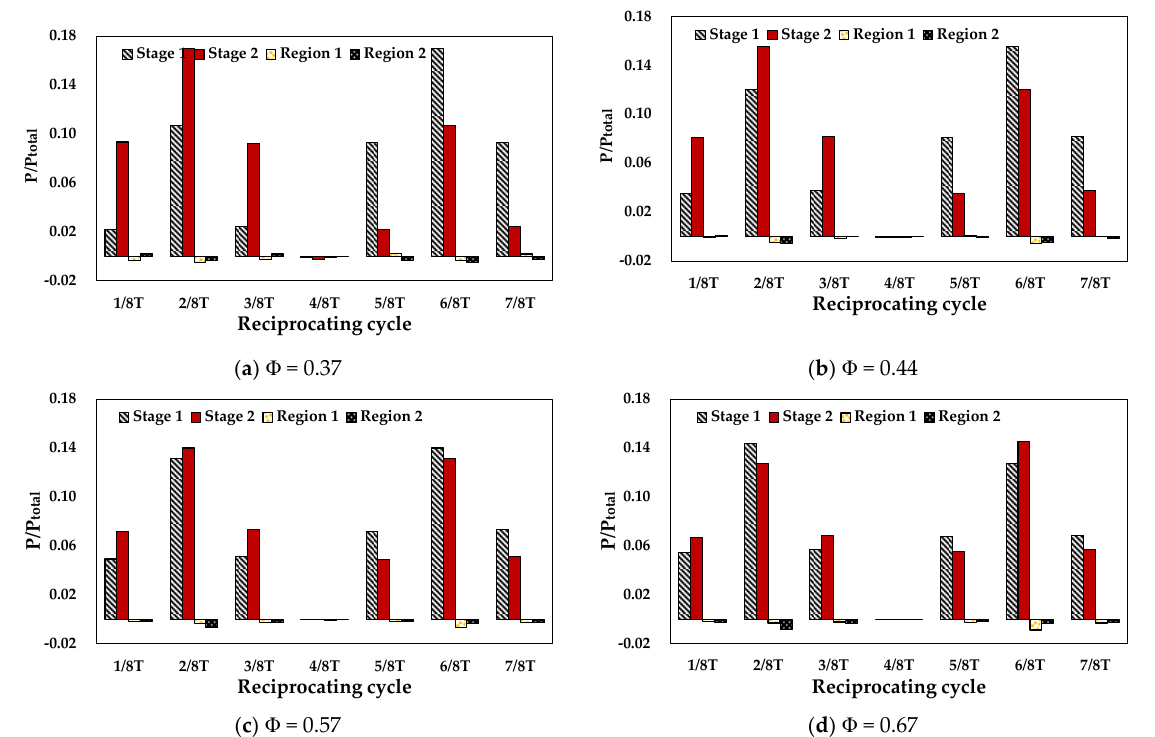
Figure 10. Variation of turbine power output for different flow coefficient.